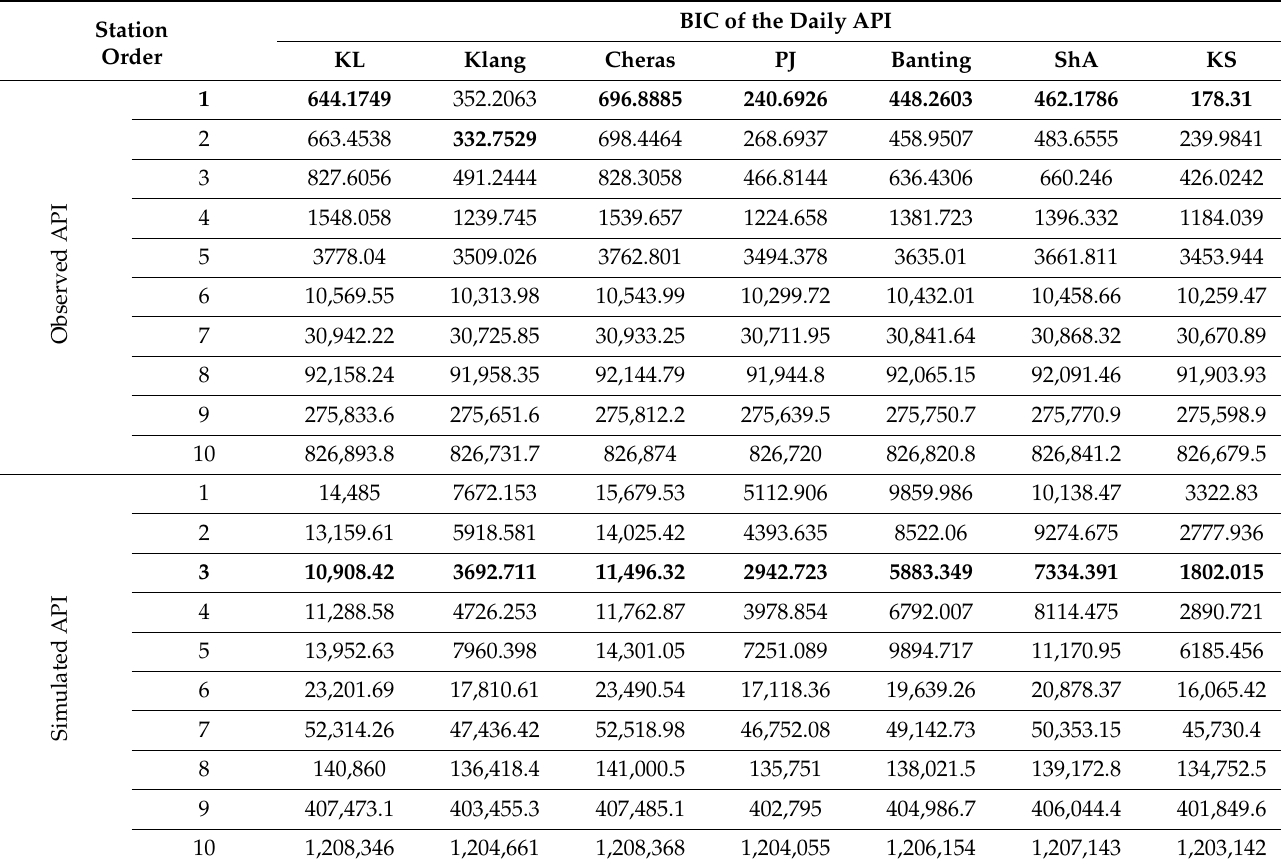
Table 4. The values of AIC and BIC for each MC model using the daily